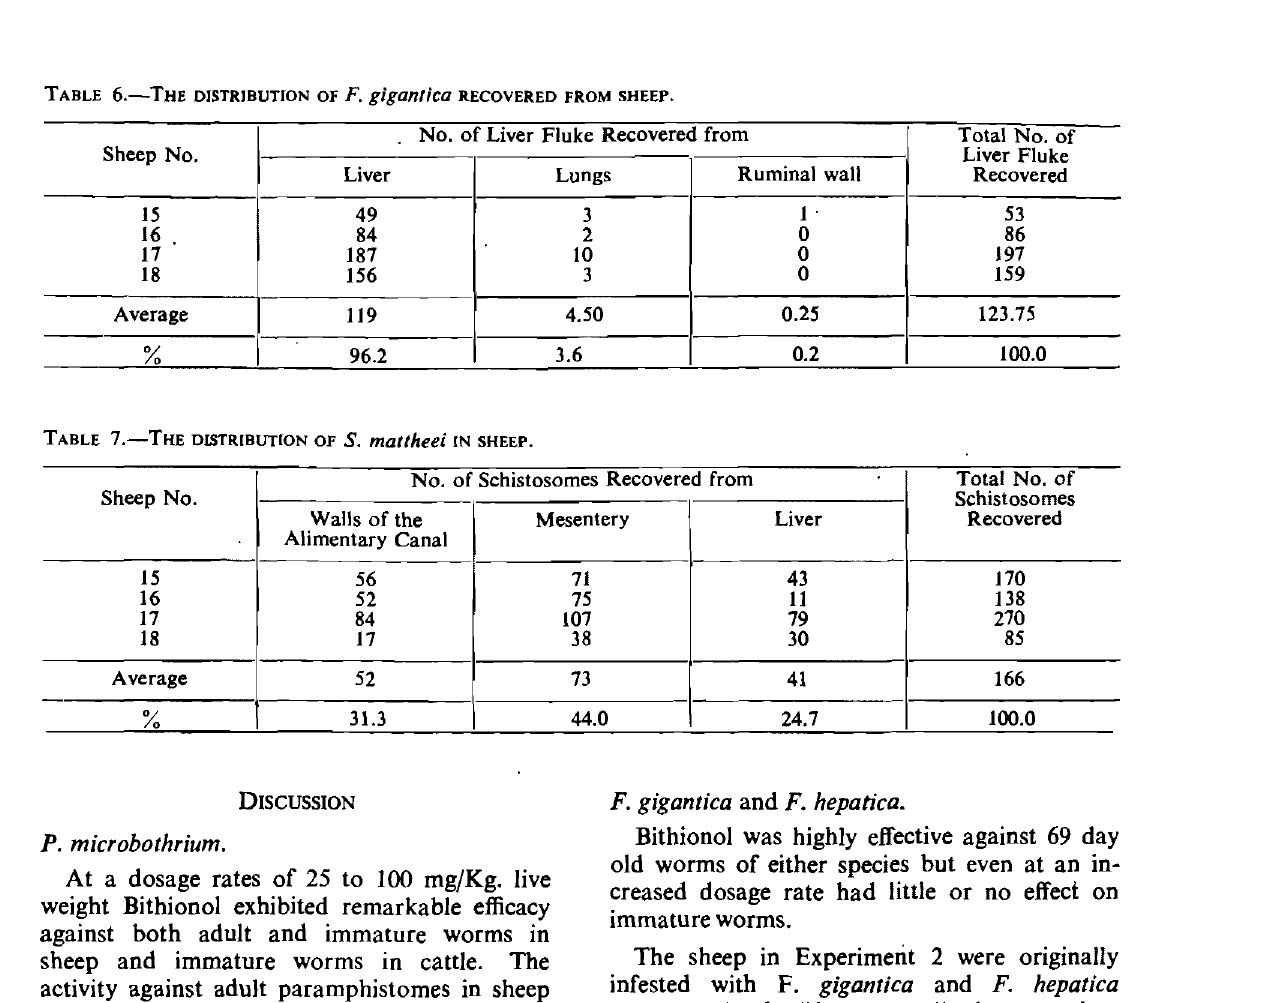
TABLE 6.-THE DISTRIBUTION OF F. gigantica RECOVERED FROM SHEEP. No. of Liver Fluke Recovered from Total No. of Sheep No.